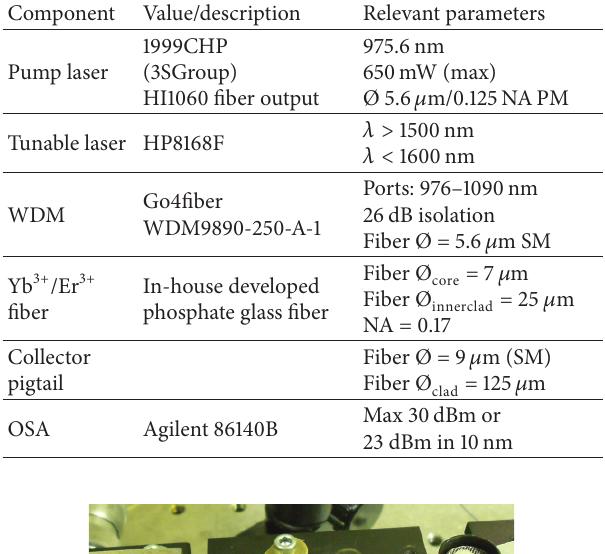
Table 1: Material and components.